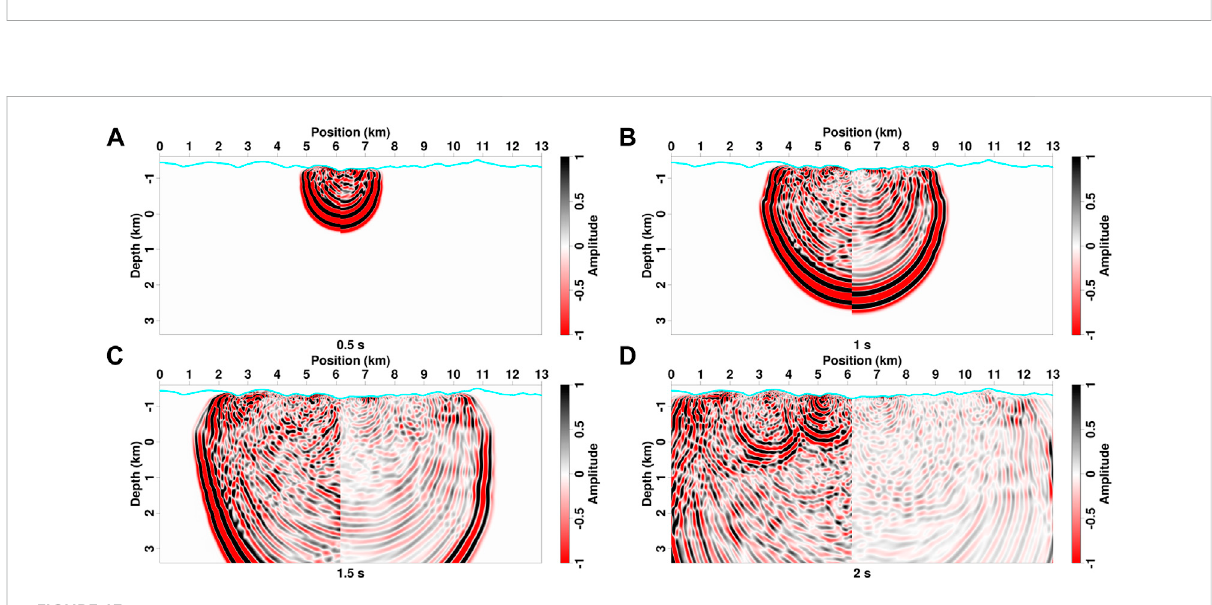
FIGURE 13 (A – D) Comparison of acoustic (left half panel) and viscoacoustic (right half panel) wave fi elds for the 2D Loess Plateau model at different propagation times. The cyan lines denote the